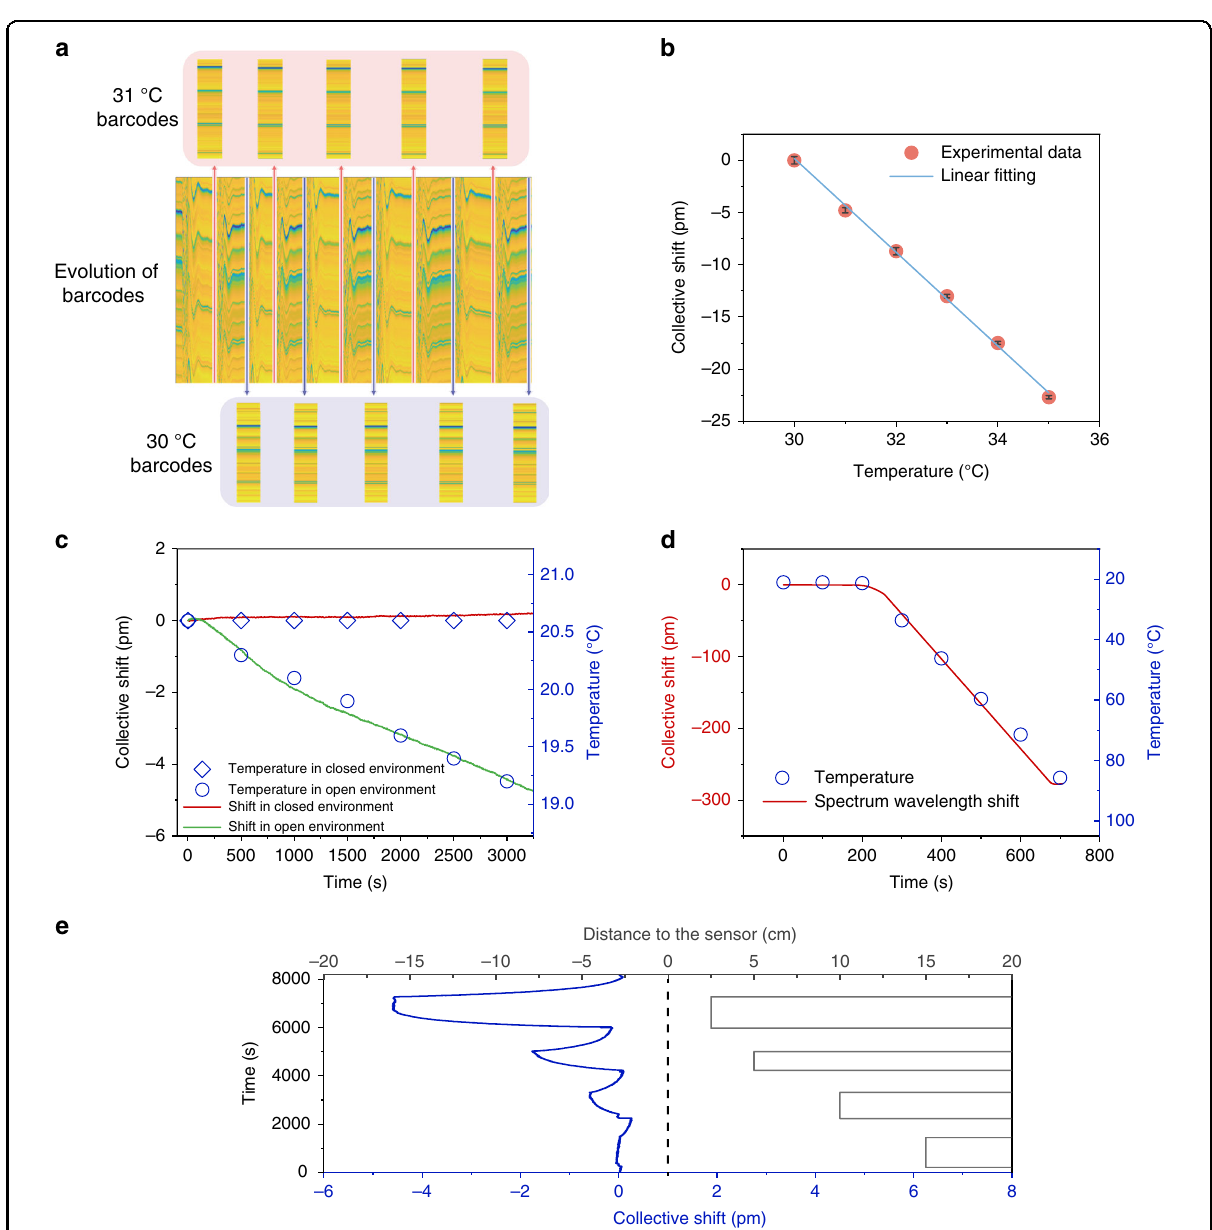
Fig. 3 Characterization of the sensing system based on WGM barcodes. a Evolution of optical barcodes between 30 °C and 31 °C for 5 cycles. b Linear dependence of the collective WGM shift on the temperature, where the red balls denote experimental measurements and the blue curve is a linear fi t to the experimental results. c Detection of temperature drift. The red curve denotes the small collective shift induced by temperature fl uctuations when the sensor is placed in a thermally isolated environment. The blue squares are the temperatures measured by a thermometer. The green curve denotes the relatively large shift when the sensor is placed in an open environment, and the blue circles are the measured temperatures. d Large-dynamic range of the measurement. The red curve denotes the collective shift in response to a large temperature change. The blue circles are the recorded temperature. e Temperature sensing of a warm object (45 °C) at different distances. Blue curve: collective shift as the object is placed at various distances. Grey line: position of the object with respect to the sensor surface marked by the dashed line at